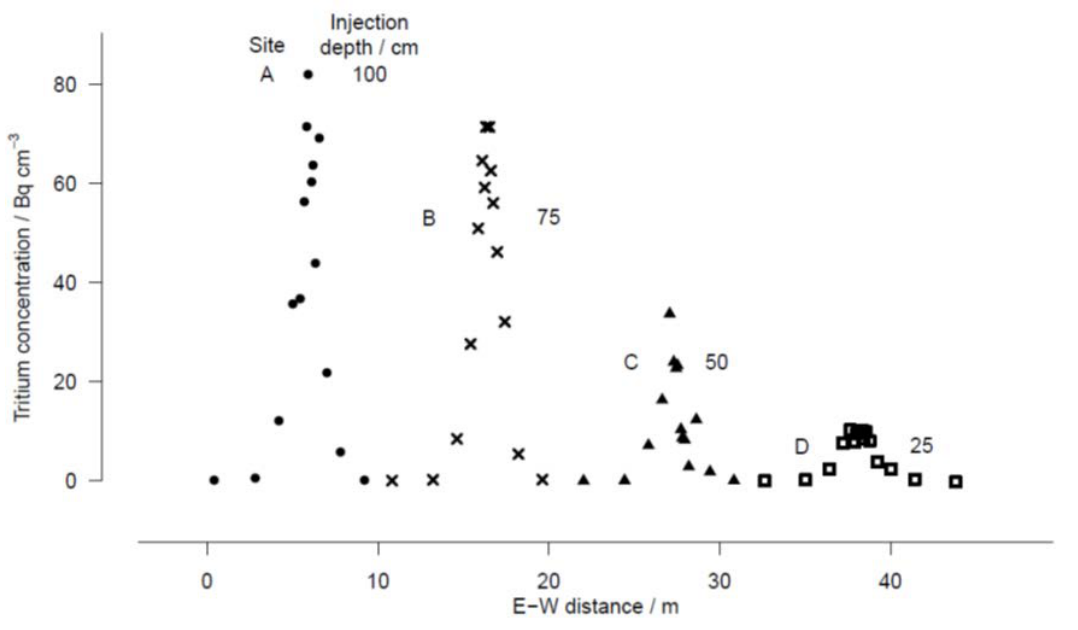
Figure 10. Mean concentration of tritium in pore water in whole core (peat and clay, if present) on a transect across the row of injection sites from E to W. Labels identify sites and the depth of the tritiated water injection 24 years before sampling. Symbols as in Figure